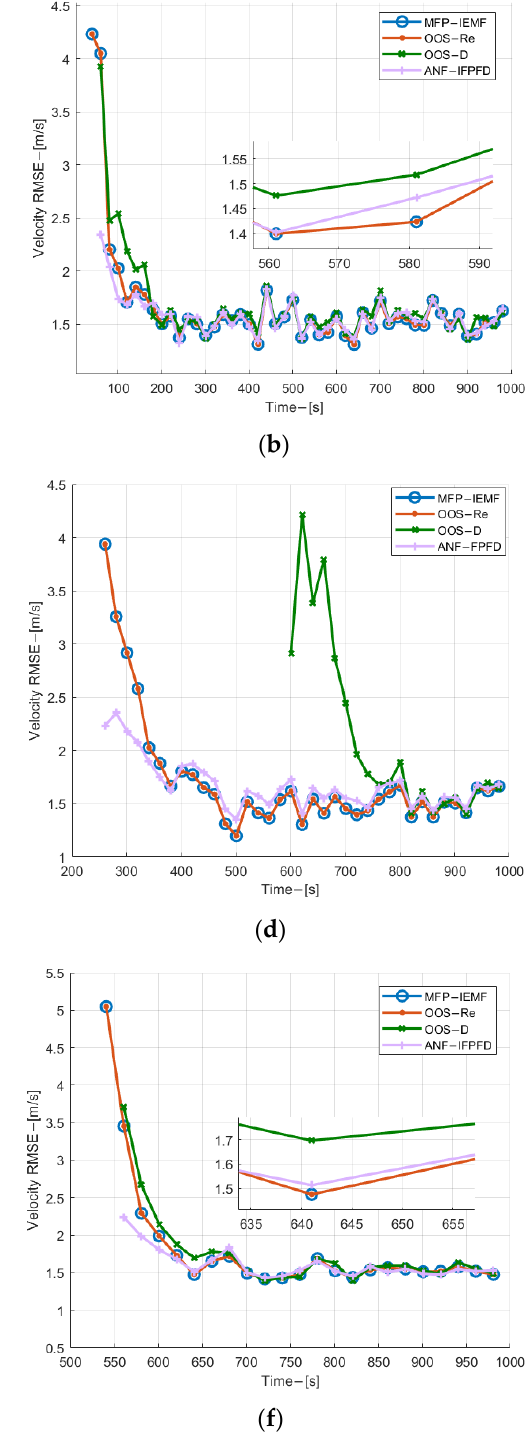
Figure 6. ( a ) Position estimation RMSE of submarine 1 in experiment 1; ( b ) velocity estimation RMSE for submarine 1 in experiment 1; ( c ) position estimation RMSE of submarine 2 in experiment 1; ( d ) velocity estimation RMSE for submarine 2 in experiment 1; ( e ) position estimation RMSE of submarine 3 in experiment 1; ( f ) velocity estimation RMSE for submarine 3 in experiment 1.